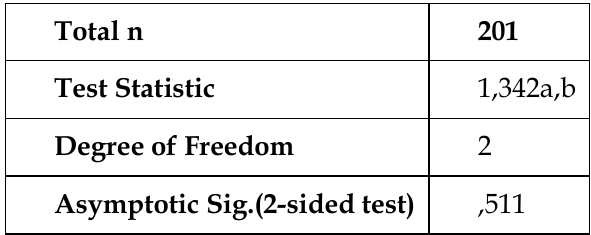
Table 17. Trust in health centre and ethnicity. Kruskal-Wallis sig. test. The test statistic is adjusted for